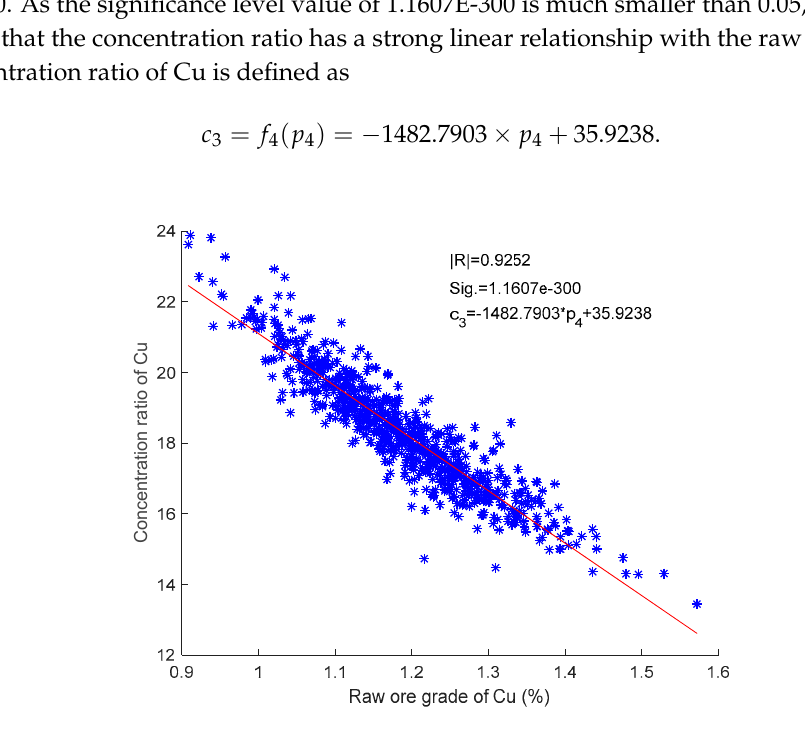
Figure 10. Linear fit of concentration ratio and raw ore grade of Cu.